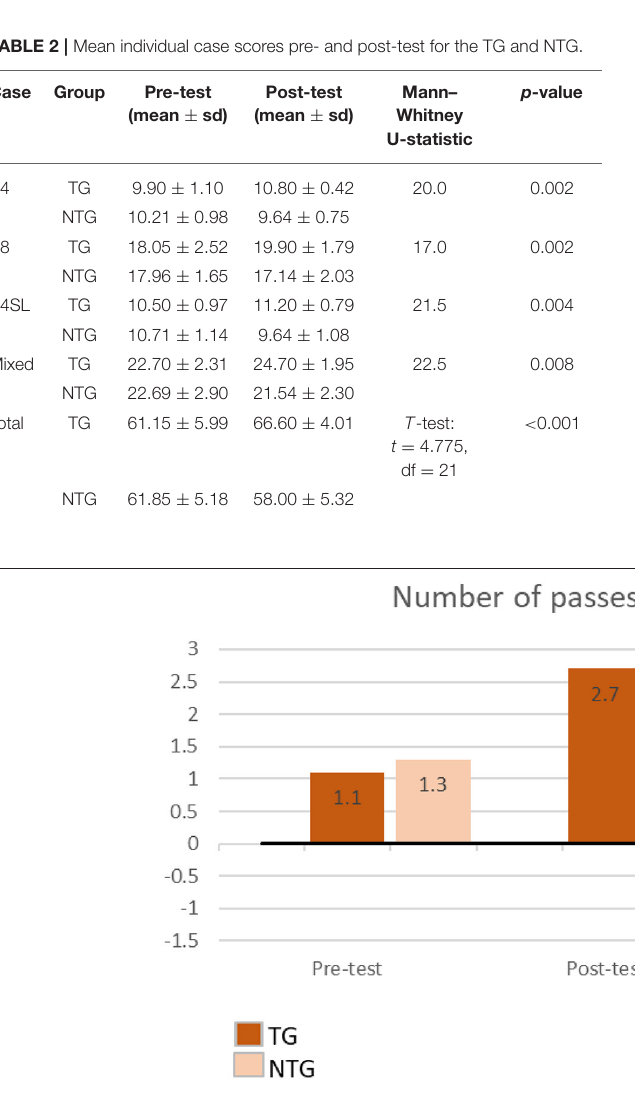
FIGURE 2 | Pre- and Post-test passes for students, assessing the change between TG and NTG.